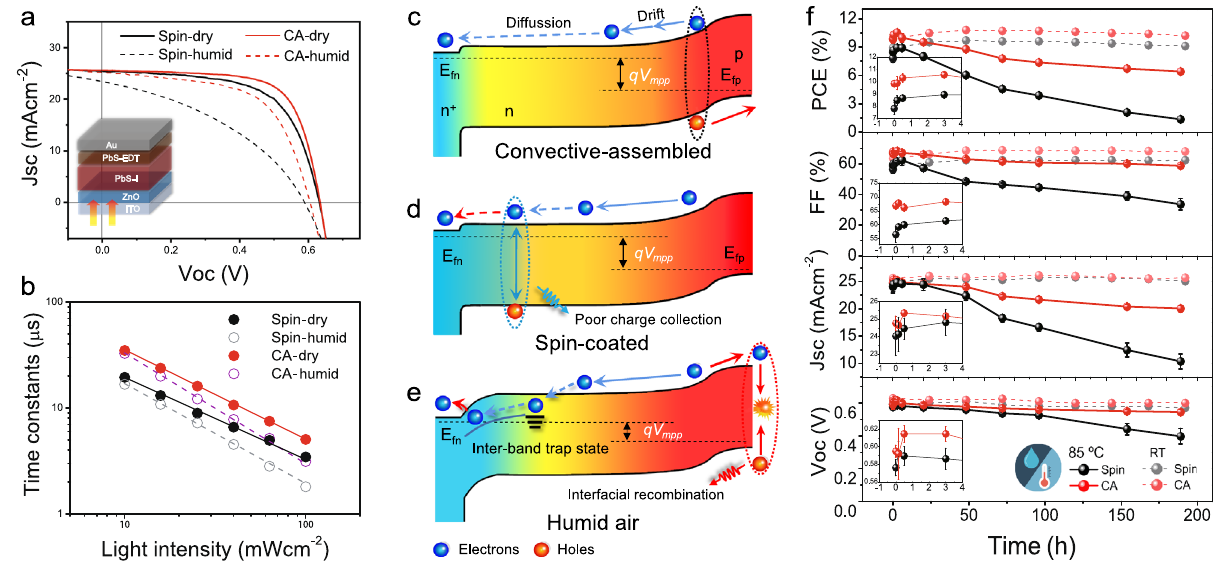
Fig. 4 Solar cell performance of CQD devices intervened by ambient water. a J − V curves of CQD solar cells fabricated through the spin coating and CA under dry air and humid air (RH ~50% – 60%), measured under AM 1.5 G solar simulator. b Light-intensity-dependent electron recombination lifetime constants for CQD devices. The relative Bode plots are shown in Supplementary Fig. 18. c – e Band diagrams for CQD cells at V MPP condition for ( c ) CA devices and ( d ) spin-coated devices prepared under dry air and ( e ) under humid air, where E Fn is the electron quasi-Fermi level, and E Fp is the hole quasi- Fermi level. f Stability of CQD devices under room temperature or under continuously heating at 85 °C in ambient air. The parameters evolutions within the early hours are inserted in each